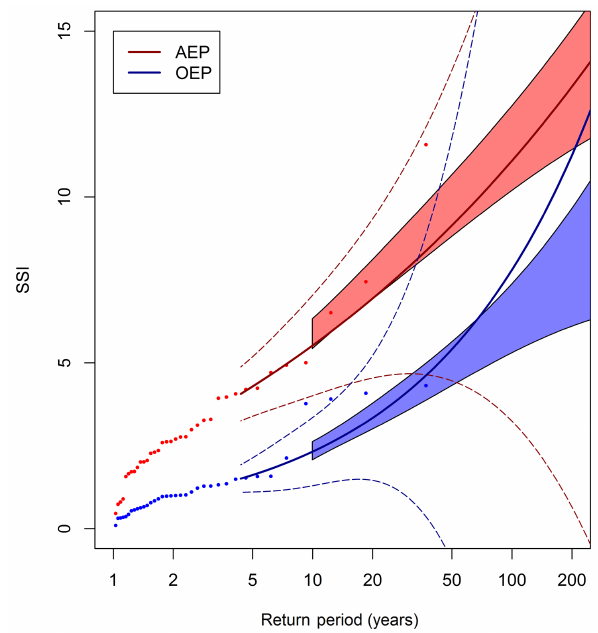
Figure A2. Return periods of the AEP (red points) and OEP (blue points) of ERA-Interim. The solid red and blue lines are GPD fits applied to the AEP and OEP using an 70th percentile threshold. The dashed red and blue regions are the associated 95% confidence intervals. The shaded red and blue regions are the 95% confidence intervals of the HiGEM_bc AEP and OEP GPD fits. The OEP and AEP are sorted independently for both ERA-Interim and HiGEM. The GPD fits and confidence intervals are only plotted above the GPD threshold of the 90th